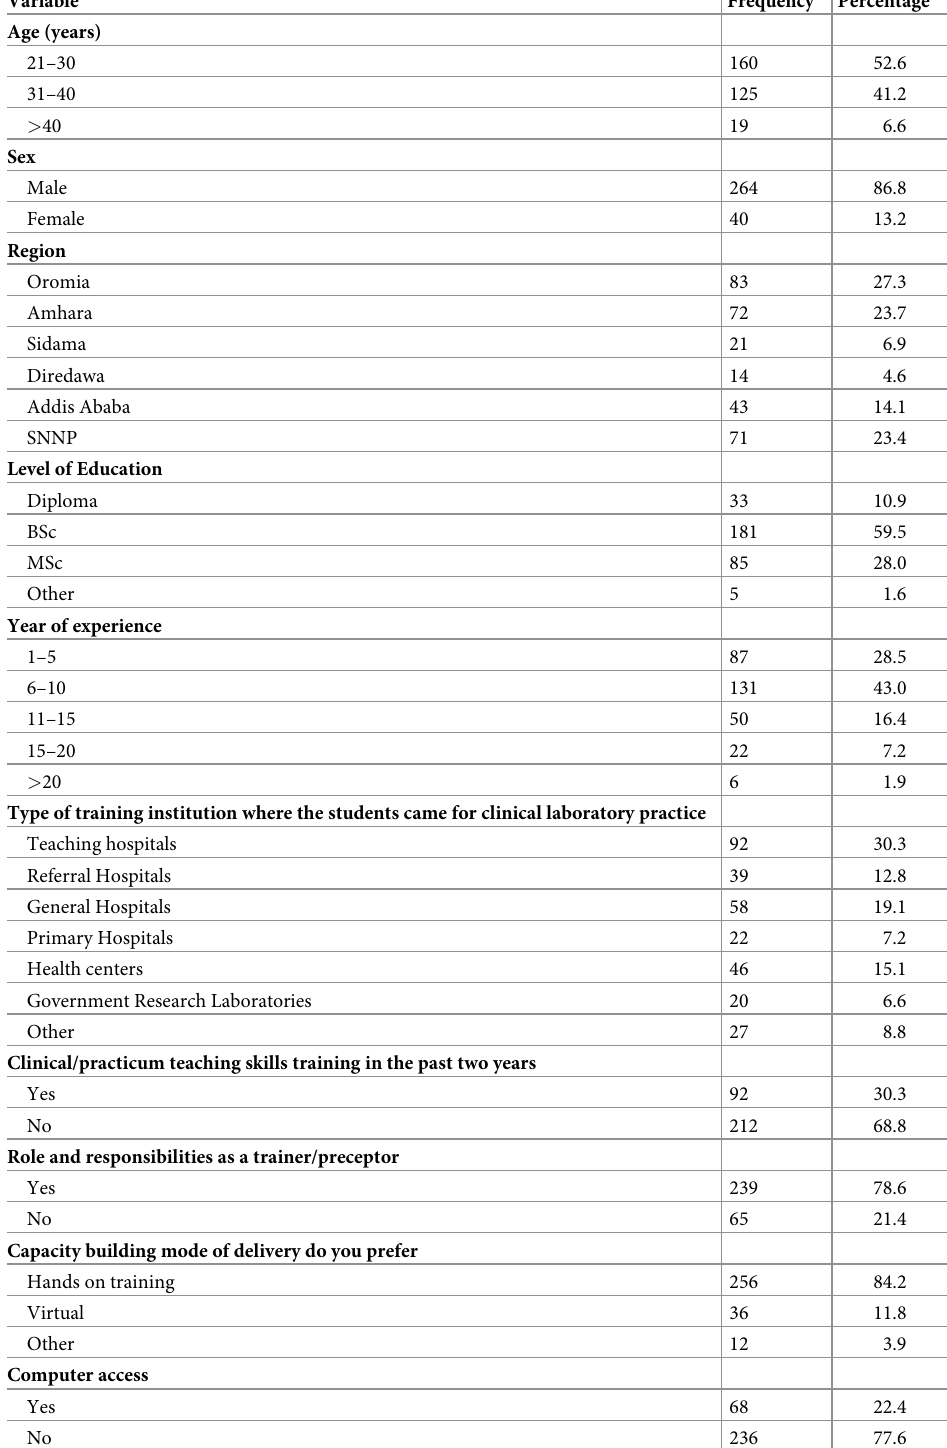
Table 1. Socio demographic characteristics of the study participants in preceptors for Medical Laboratory Science clinical practicum education programs in Ethiopia, 2021(N =